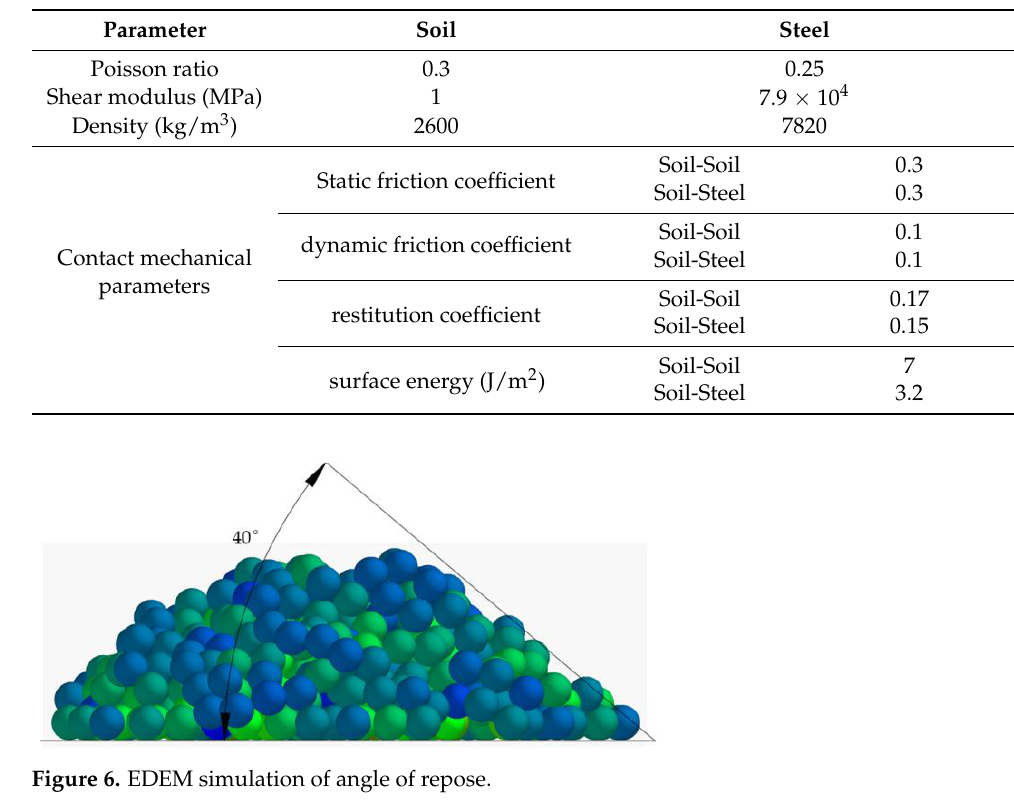
Table 1. Parameter table for microscopic discrete element method simulation.